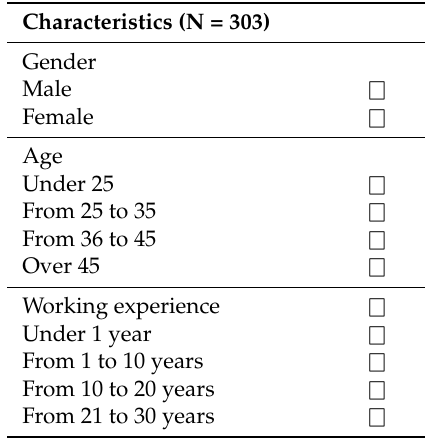
Table A1. Demographic